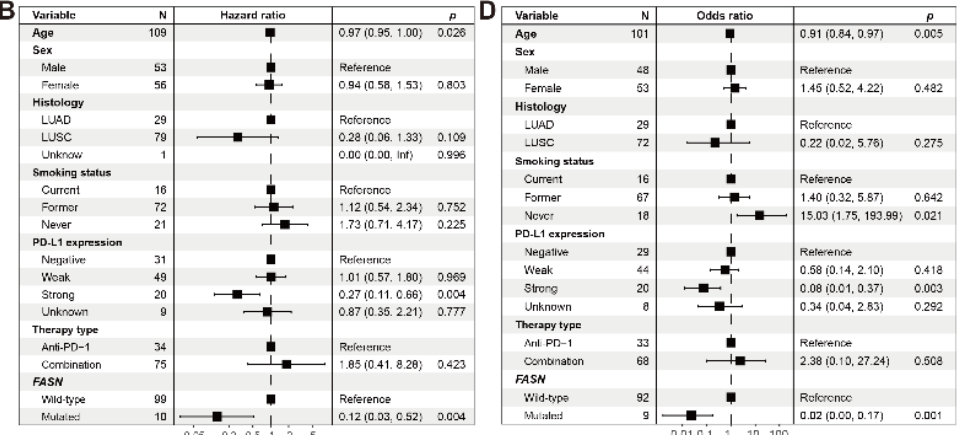
Figure 4. FASN mutations predictive of ICI outcome and response in NSCLC. ( A ) Kaplan–Meier survival curves stratified based on FASN mutational status. ( B ) Multivariate Cox regression model of FASN mutations was conducted with multiple confounding factors taken into account. ( C ) Distinct ICI response rates of FASN mutated versus wild-type subgroups. ( D ) Multivariate logistic regression model of FASN mutations was conducted with multiple confounding factors taken into account. An enhanced TMB was detected in the FASN mutant group ( p = 0.016; Figure 5A). Three mutational signatures were determined against NSCLC mutation data (Table S6). A multivariable logistic analysis with clinicopathologic factors, mutational signatures, and DNA repair regulator mutations was incorporated; the link between FASN alterations and elevated TMB was still noticed ( p = 0.026; Figure 5B). FASN mutations were also connected with an increased NB ( p = 0.006; Figure 5C). Similarly, based on mutation data from the TCGA NSCLC cohort, the significantly enhanced TMB and NB were also found in the FASN mutant subgroup ( p = 0.002 and 0.014; Figure 5D,E).